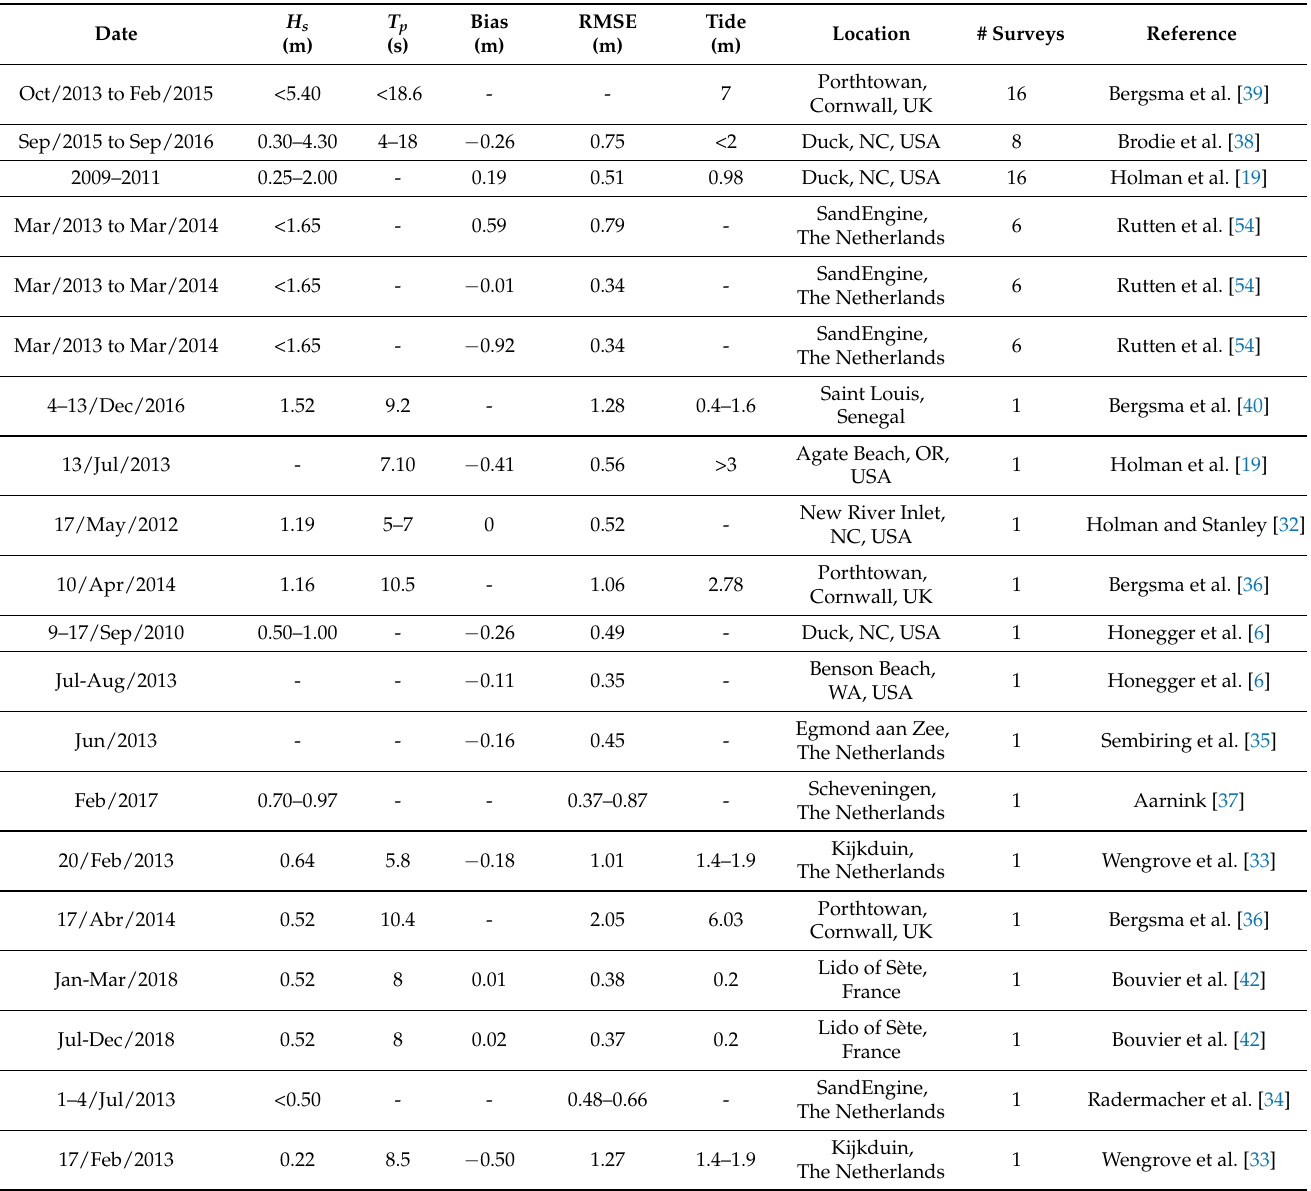
Table 1. cBathy performance statistics from prior work, organized by decreasing H s . Positive (negative) bias corresponds to cBathy underestimated (overestimated) depth relative to the survey. Note that performance statistics are not all directly comparable, as validations were sometimes performed in different areas (e.g., inner surf zone). Adapted from Brodie et al. [38], Copyright 2018, with permission from